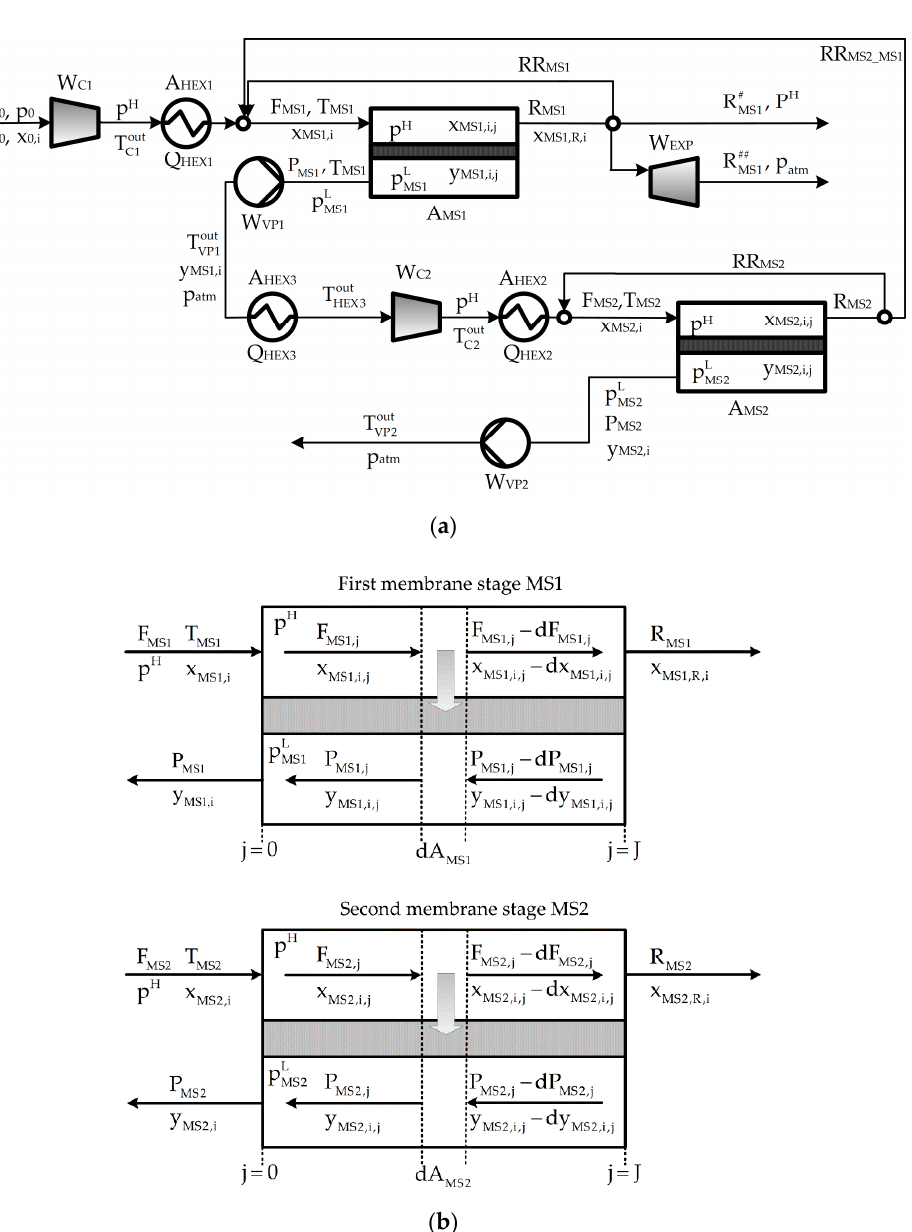
Figure 2. Schematic representation and nomenclature: ( a ) whole process; ( b ) membrane modules. (F indicates flow rate, Q heat load, T temperature, p pressure, x composition in feed/retentate streams, y composition in permeate streams, W power, A area of membrane and area of heat exchanger. The subscript i represents a mixture component, subscript j a discretization point along the membrane length, and subscript 0 the fresh feed).